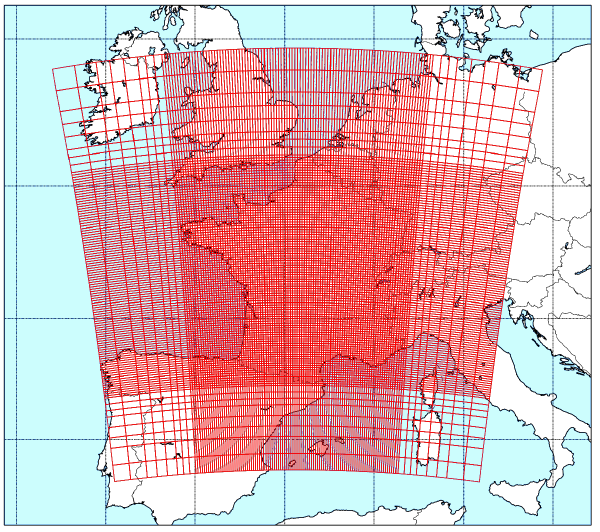
Figure 3. The colours identify regions for emissions, 26 regions in France (numbers), 4 “outside” regions (letters A to D) and 1 sea region (E). Stars and names are sites at which measurements were available in 2012 for CH 4 , see characteristics in Table